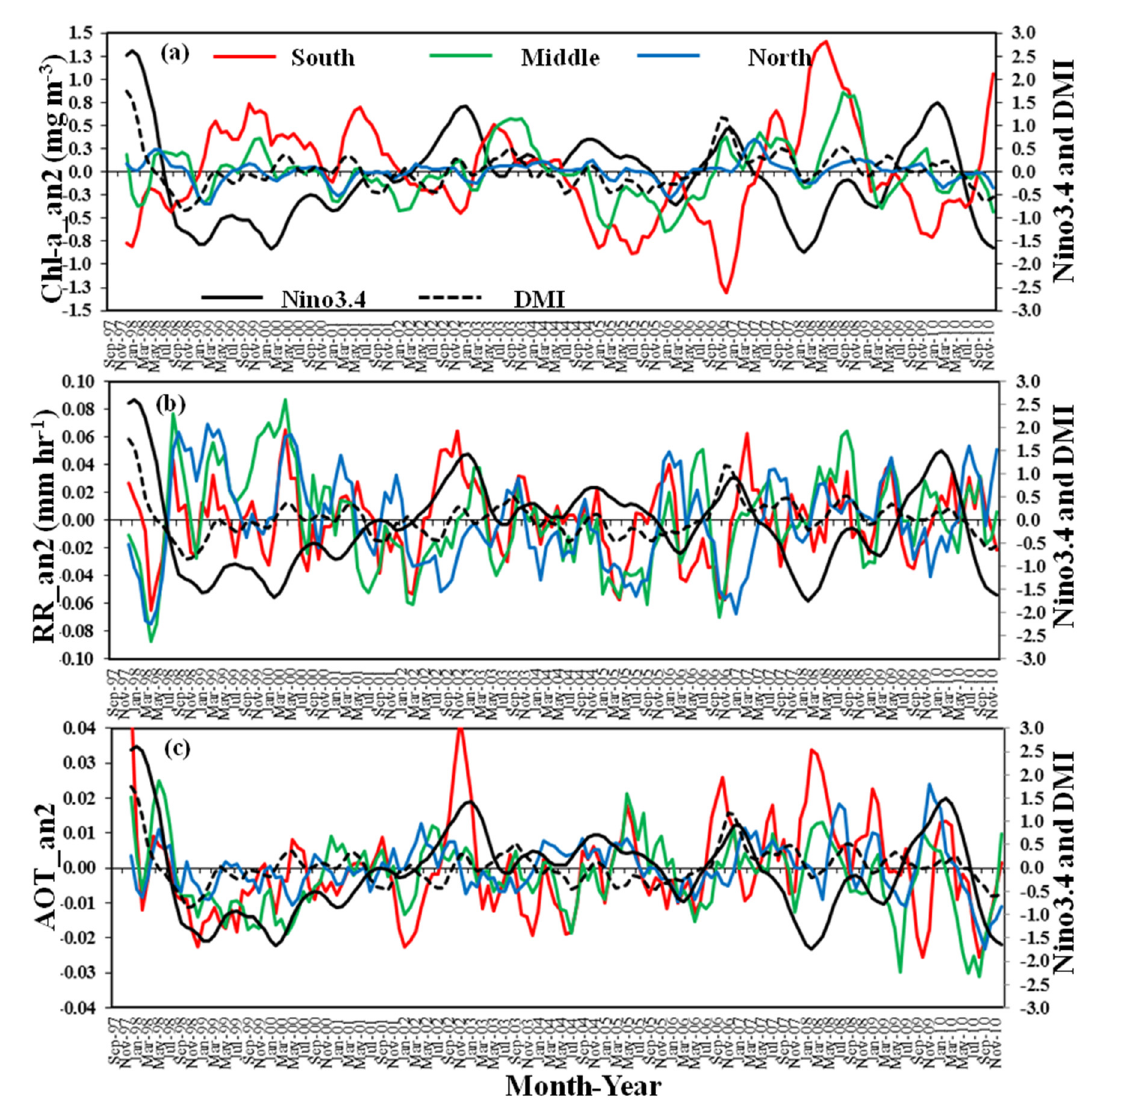
Figure 4. ( a ) Four-month moving average of SeaWiFS chlorophyll- a concentration anomaly (Chl- a _an2), ( b ) TRMM rain rate anomaly (RR_an2) and ( c ) SeaWiFS aerosol optical thickness anomaly (AOT_an2) (seasonality-removed and detrended variable anomalies) in the northern, middle and southern regions of the SM during the period of the SeaWiFS full mission. Four-month moving averages of Nino3.4 and the Dipole Mode Index (DMI) are also